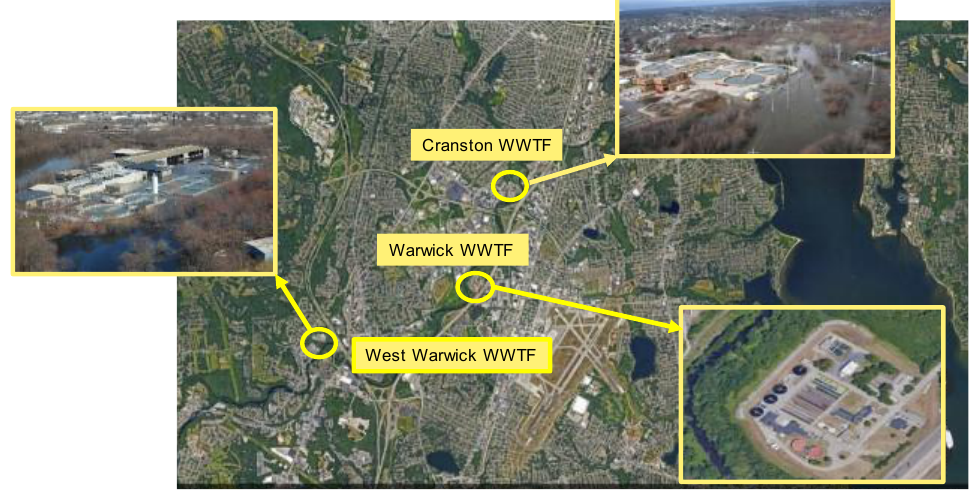
Figure 7. Locations of the West Warwick, Cranston, and Warwick WWTF on the Pawtuxet River, RI. Center map shows the location of the facilities relative to upper Narragansett Bay and the Providence River.